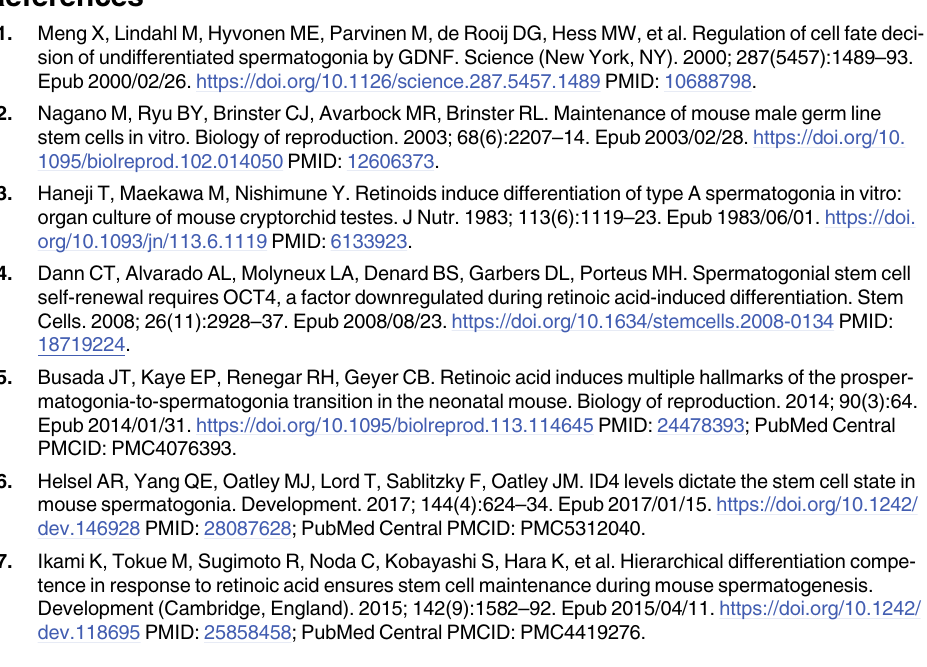
S4 Table. Comparison of fold-change in mRNA levels ( Rosa- Δ Ctnnb1 vs Rosa-control ) for selected genes, as determined by RNAseq and